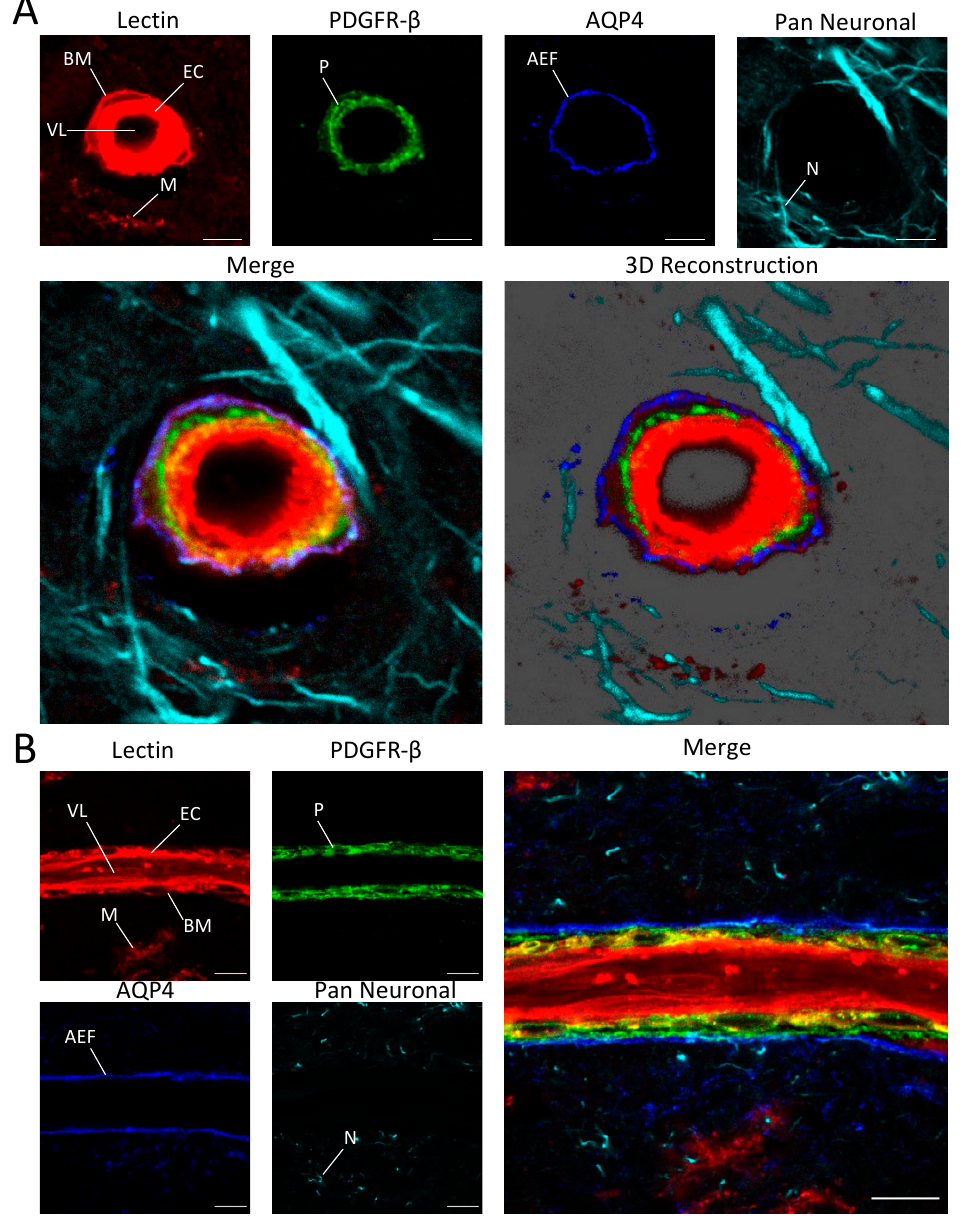
Figure 3. Images of capillary cross-section ( A ) and a longitudinal cross-section of a precapillary arteriole ( B ) in the cortex showing endothelial cells (EC), the casement membrane (BM), microglia (M), pericytes (P), astrocyte end feet (AEF), the vessel lumen (VL) and neurites (N). Scale bar = 5 μ m in (B).